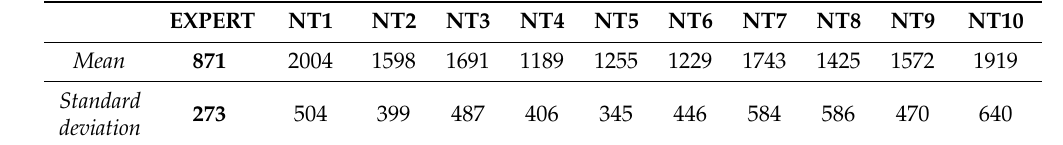
Table 2. Expert session statistics for the parameter relative to task precision (off-target score in pixels) compared with the session statistics of ten novice trainees (NT) for an equivalent number of individual simulator training trials (N = 120) across camera view conditions.